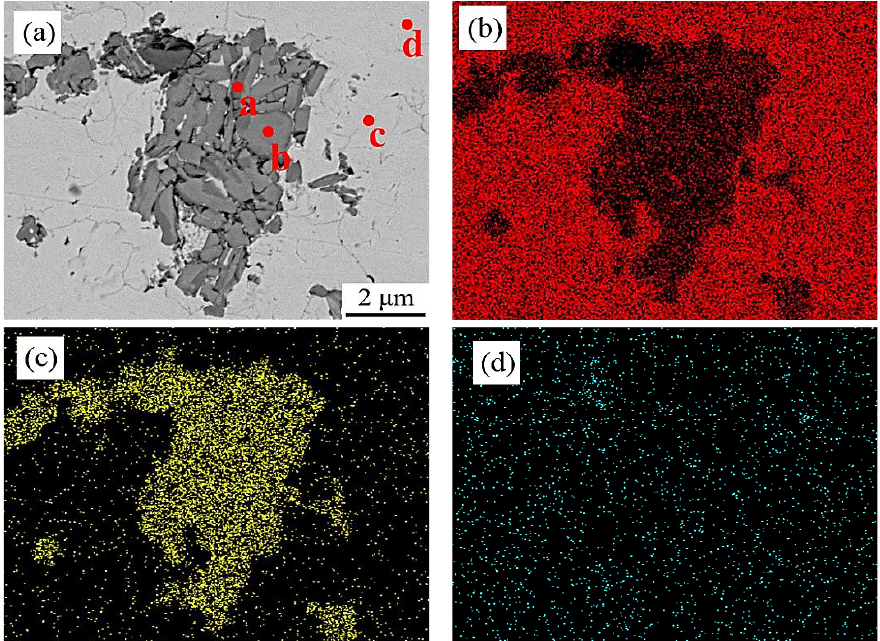
Figure 3. Typical morphology and EDS mapping of Ti 3 AlC 2 /Cu composites when the volume fraction of Ti 3 AlC 2 is 10 vol.%: ( a ) Ti 3 AlC 2 particles agglomerate and ( b ) scanning results of the Cu element, ( c ) Ti element and ( d ) Al element.